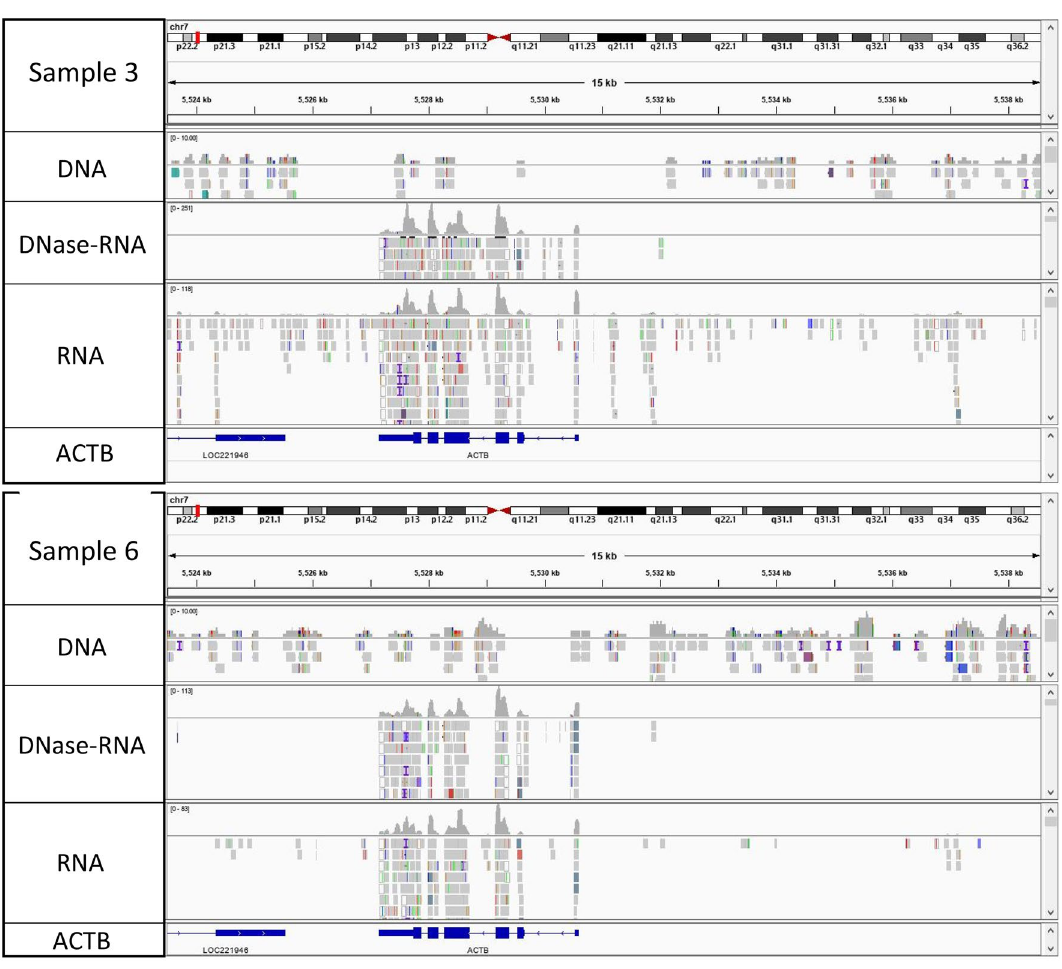
Figure 2. Read distribution and coverage of the human actin beta gene (ACTB) in one CIN3 (sample 3, top panel) and one normal (sample 6, bottom panel) cervical swab by DNA sequencing at the top, RNA sequencing after DNase-treatment in the middle and RNA sequencing without DNase-treatment at the bottom for each of the two samples. The genomic location within chromosome 7 is visualized at the top by a red box and the ACTB gene at the bottom, where the exons are represented by the blue boxes. (Image created using Integrative genomics viewer v. 2.8.13, https:// softw are. broad insti tute. org/ softw are/ igv/) 30–32